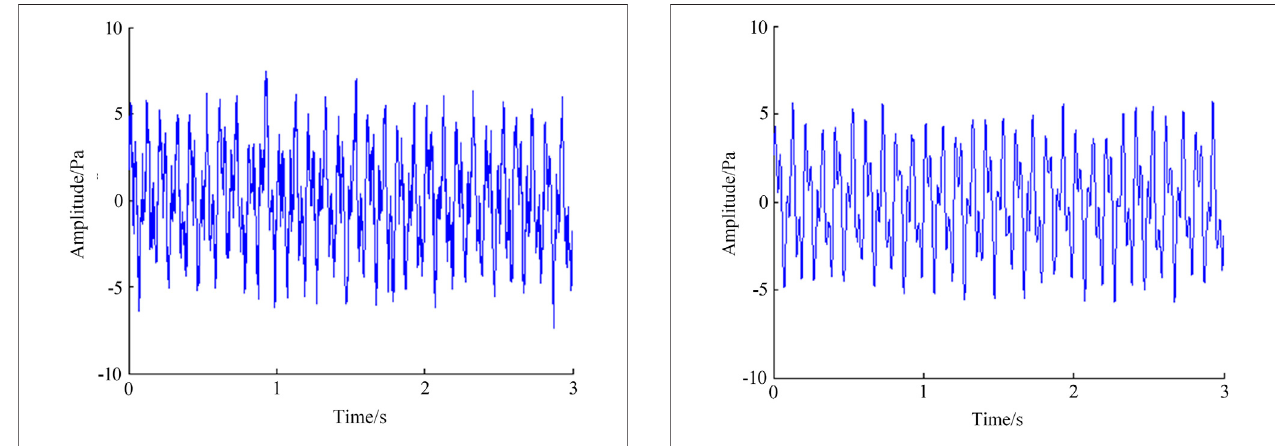
FIGURE 11 | Waveform after denoising by EMD.